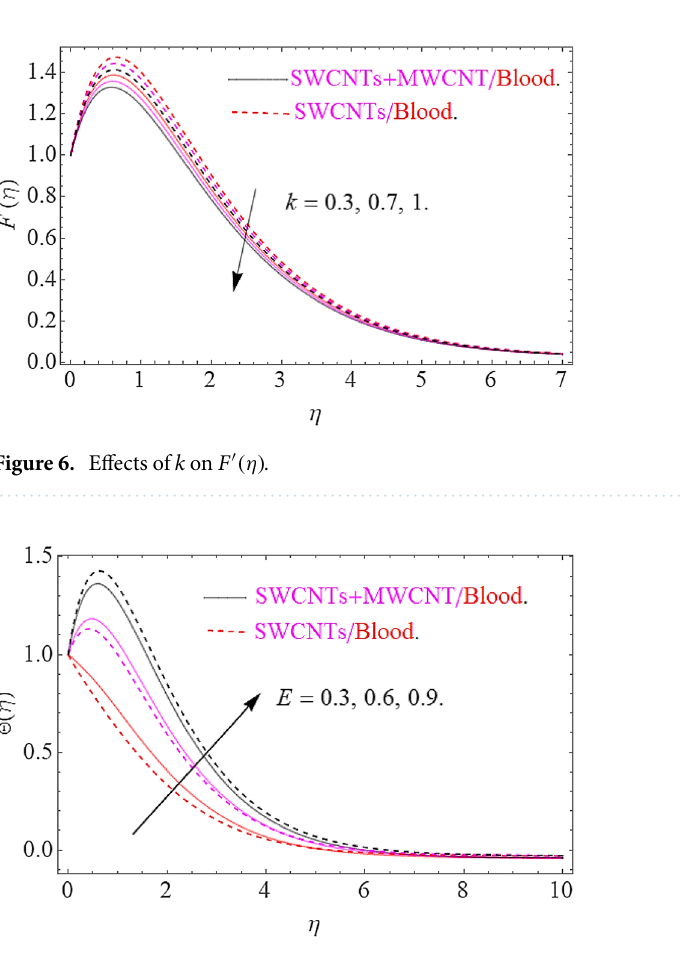
Figure 7. Impact of E on �(η) .